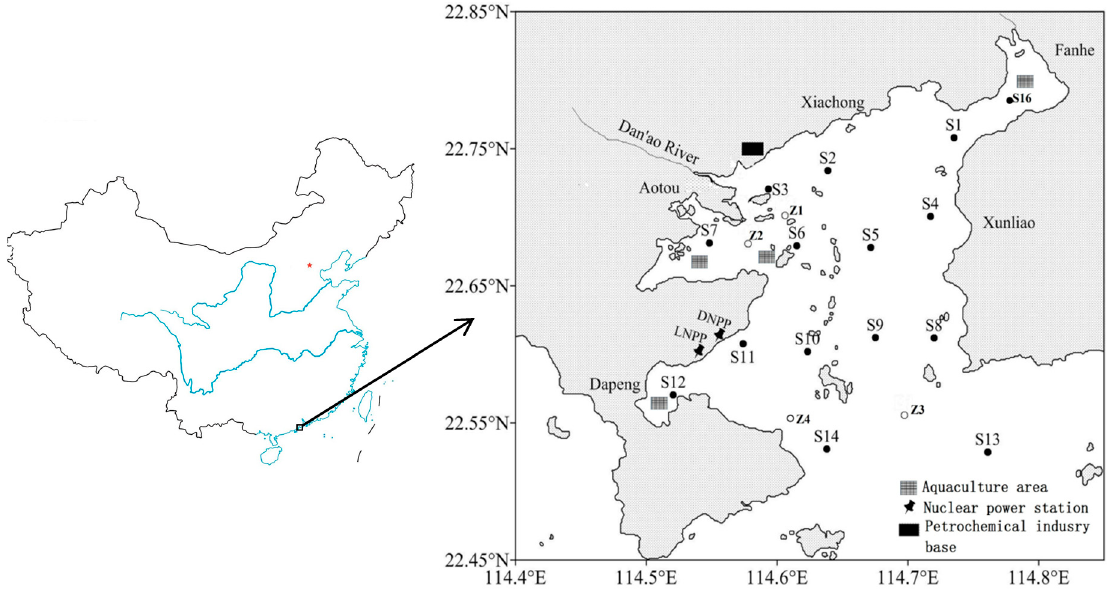
Figure 1. Sampling sites in Daya Bay.